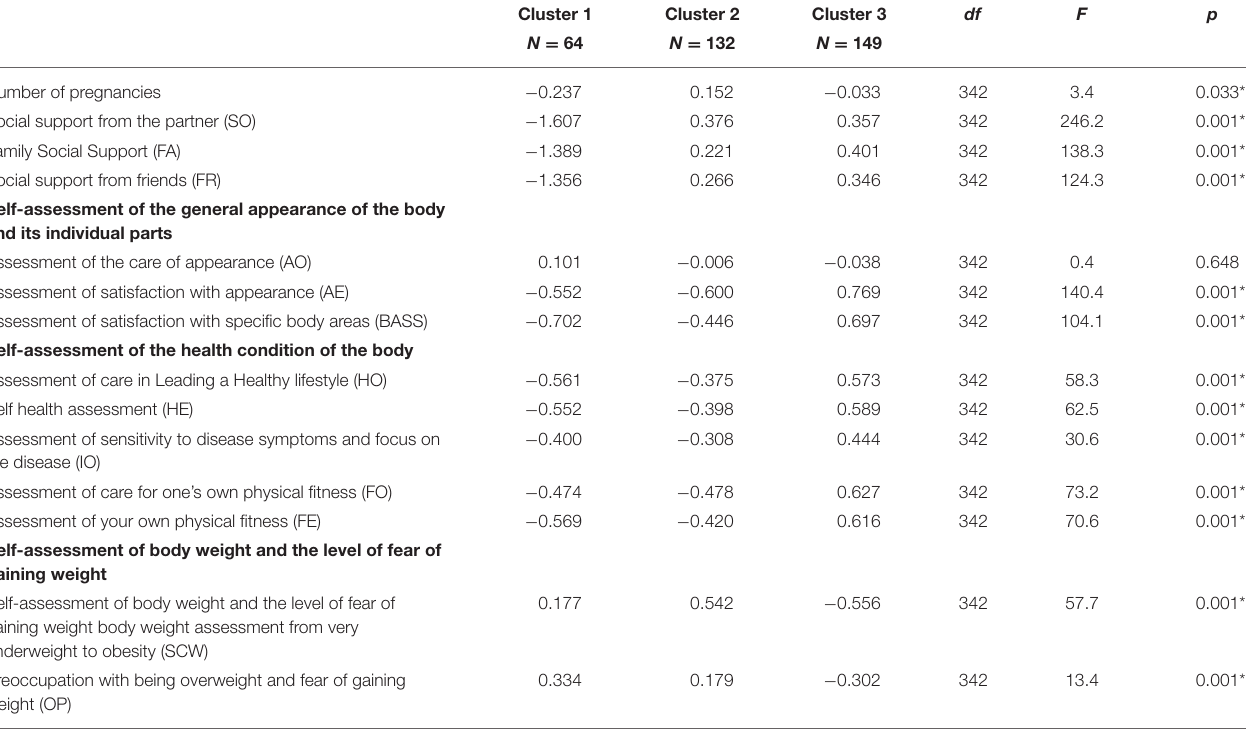
TABLE 9 | Cluster analysis using the k-means method in the group of women diagnosed with DRAM ( N =